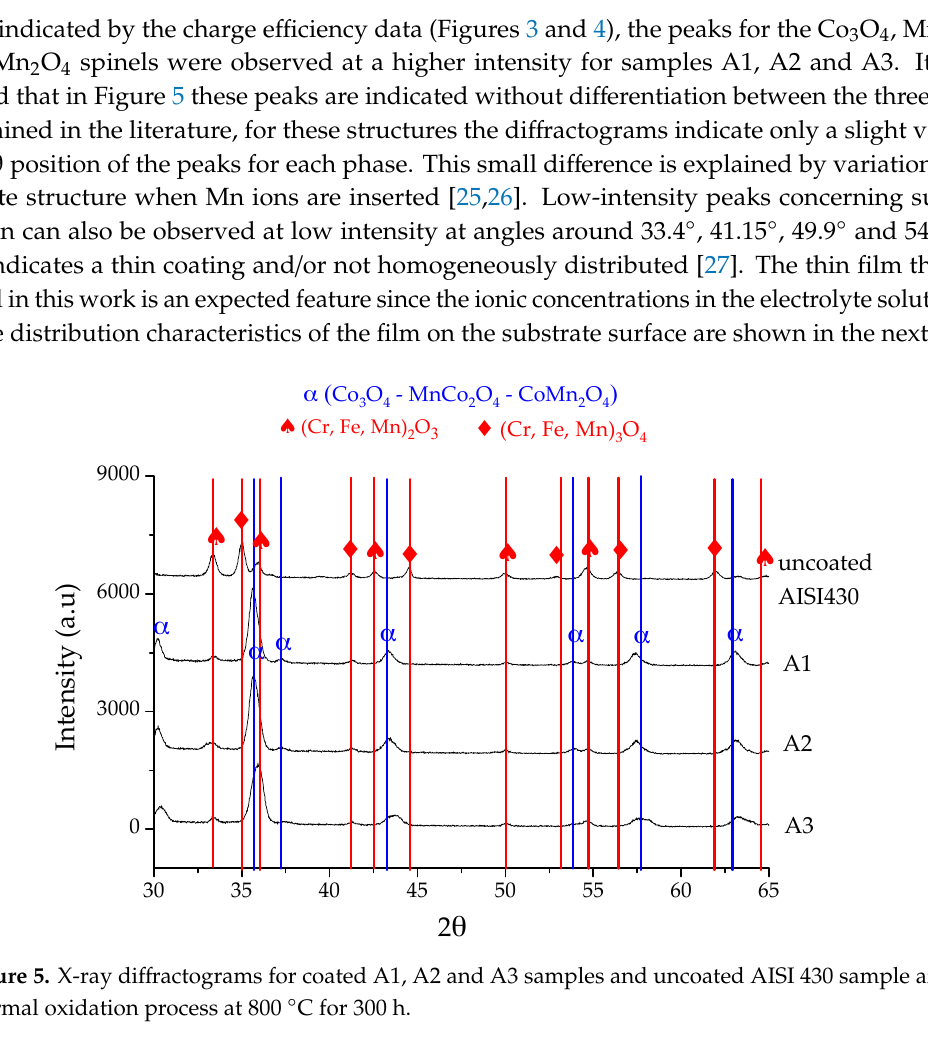
Figure 6. X-ray diffractograms for coated A1, A2 and A3 samples and uncoated AISI 430 sample after thermal oxidation process at 800 °C for 300 h. 3.4. SEM and EDS Figure 7 shows SEM images of the uncoated stainless steel sample surface and samples A1, A2 and A3, heat-treated at 800 °C for 300 h. In Figures 8 and 9 chemical map cross-sectional